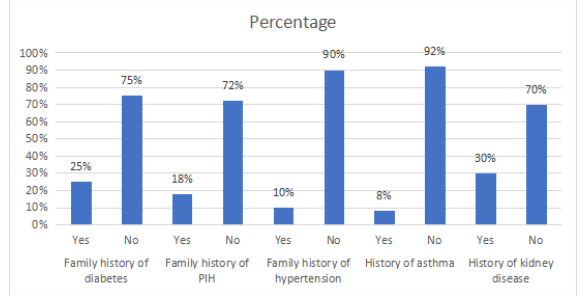
Figure 2. Evaluation of risk